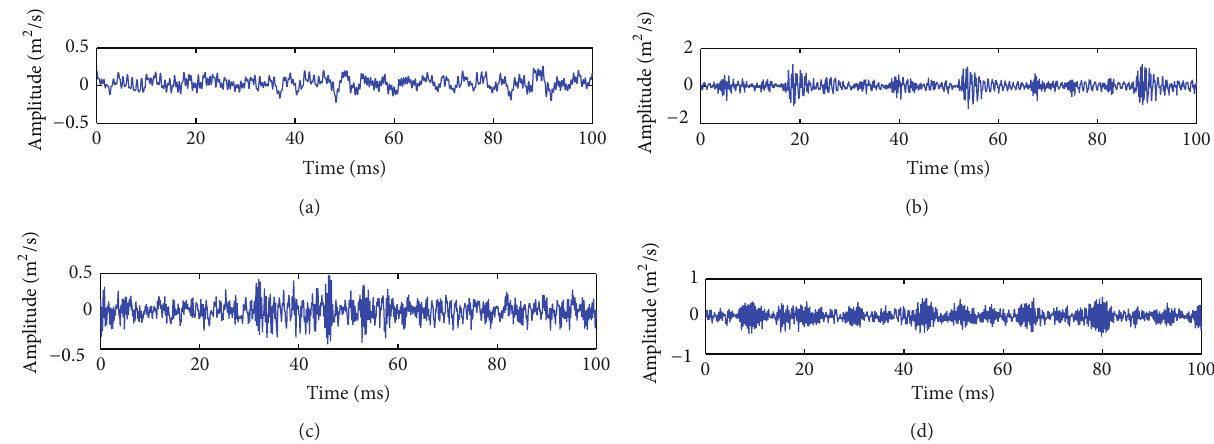
Figure 4: Waveform of vibration signals from bearing under four conditions: (a) normal, (b) inner race fault, (c) ball fault, and (d) outer race fault.